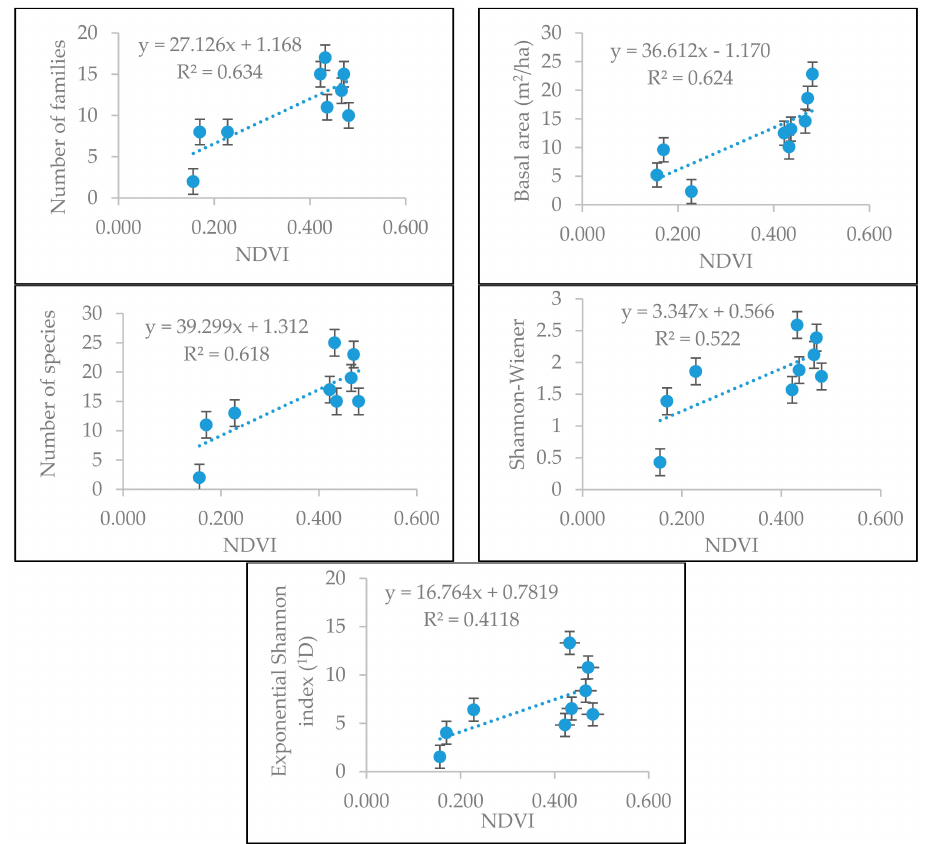
Figure 5. Linear regression between NDVI and number of families, number of species, total basal area, Shannon-Wiener’s index and exponential Shannon index, of the study